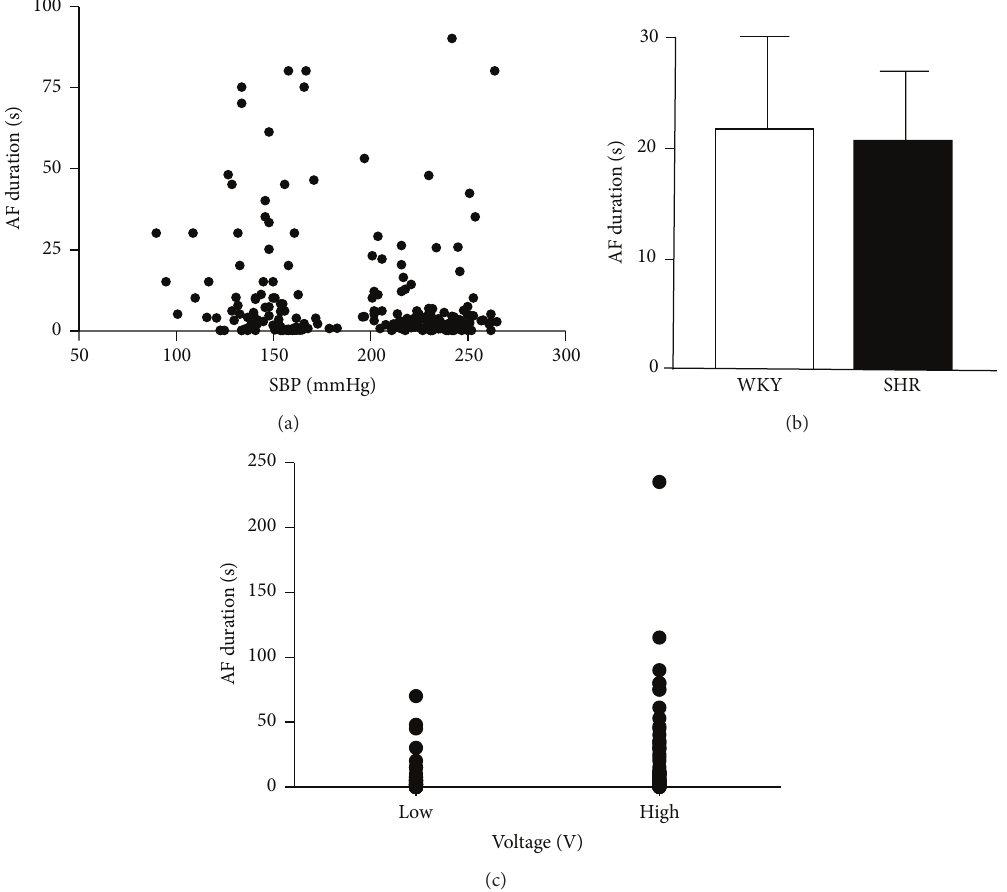
Figure 2: (a) Relationship between the duration of atrial fibrillation (AF) with low (5V) and high (20 V) voltage stimulus and systolic blood pressure (SBP) in WKY and SHR. (b) The duration of AF with low (5V) and high (20V) voltage stimulus in WKY and SHR. (c) Duration of AF in low (5V, low) and high (20V, high) voltage